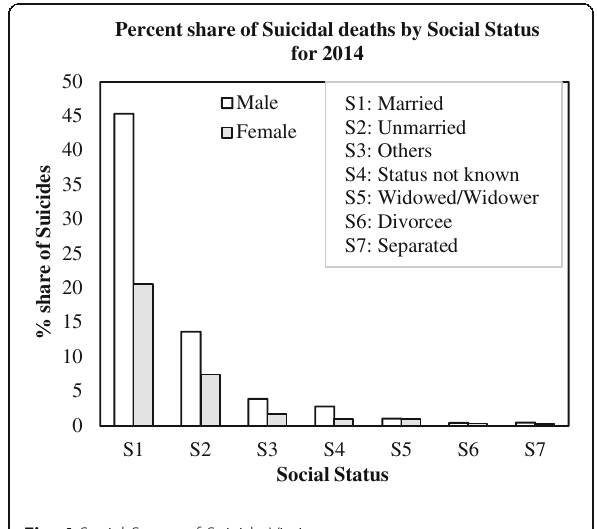
Fig. 4 Social Status of Suicide Victims